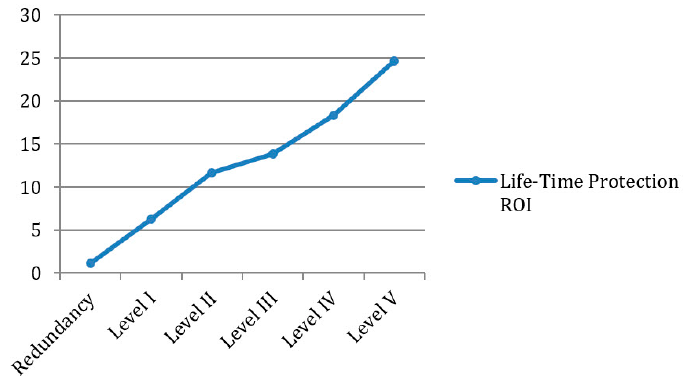
Figure 5. Comparison of ROI between Protection Methodologies.